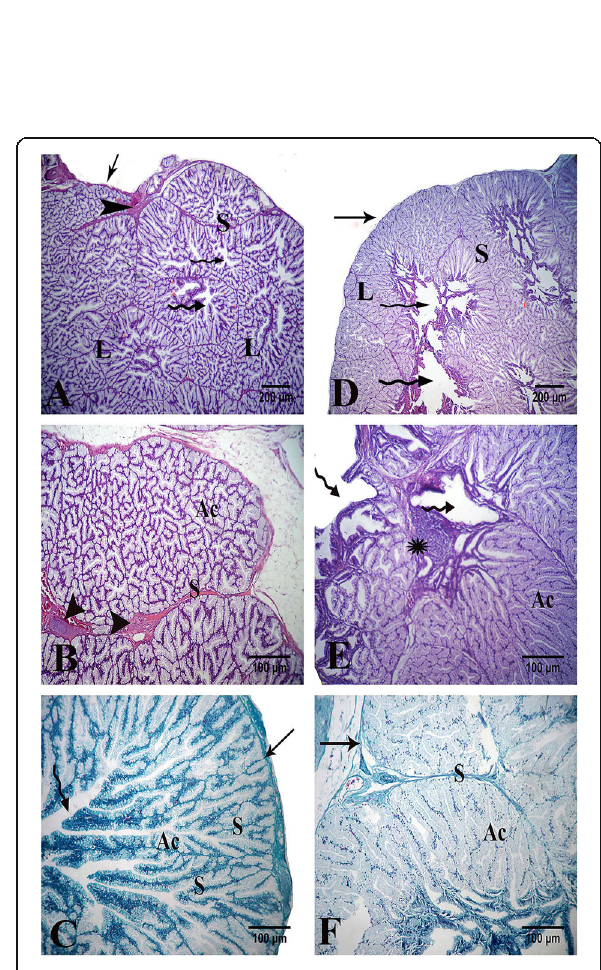
Fig. 7 Light micrograph of the HG of duck ( A , B , C ) and goose ( D , E , F ) showed the lobules (L) formed from secretory acini (Ac) and covered by capsule (arrow) containing blood vessels (red arrow heads), septa (S) containing blood vessel and nerve fiber (black arrow heads), lymphatic nodule in goose (star), and irregular lumen of duct (zigzag arrow). Stain, H&E in ( A , B , D , E ) and Masson trichrome in ( C , F )